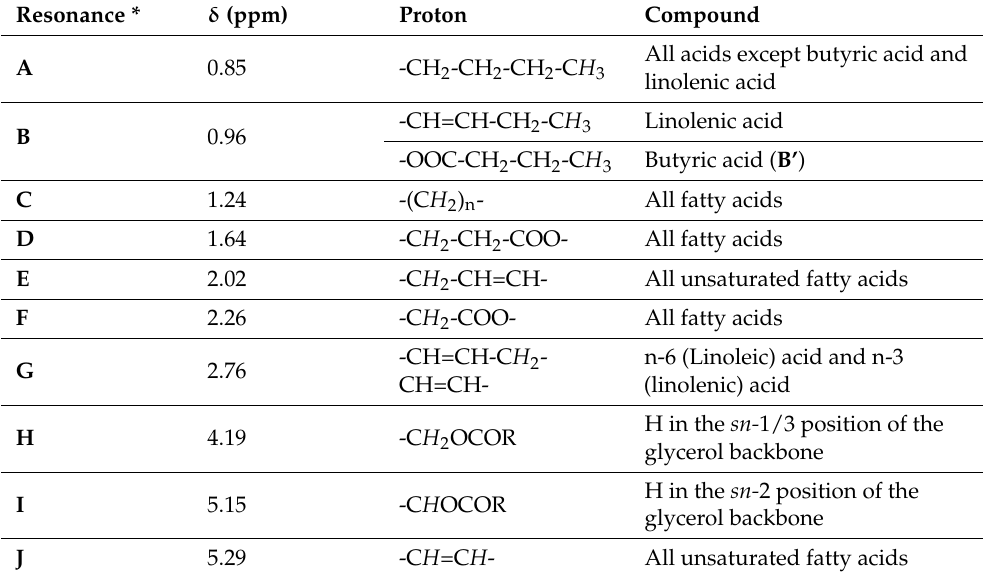
Table 1. Chemical shifts and peak assignment of 1 H-NMR spectra of milk fats. Adapted with permission from Refs. [12,19]. Copyright 2004, Eur. J. Lipid Sci. Technol .; Copyright 2021, J. Dairy Sci